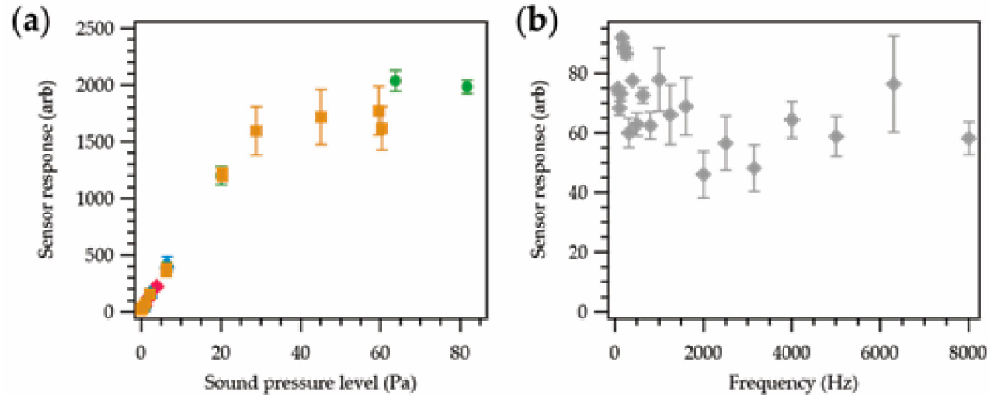
Figure 5. Sensor response for an acoustic sensing yarn. All data points were the average of five repeat measurements. ( a ) Sensor response as a function of sound pressure level at four frequencies, 125 Hz (green; ), 1000 Hz (yellow; ), 4000 Hz (blue; ), and 8000 Hz (pink; ). Tests were carried out between 0.02 and 82 Pa, and gave similar responses regardless of frequency. It should be noted that higher SPLs were not possible for all frequencies explored, given the limitations of the testing apparatus. ( b ) Sensor response as a function of frequency at a fixed sound pressure level of 1.03 ± 0.05 Pa.